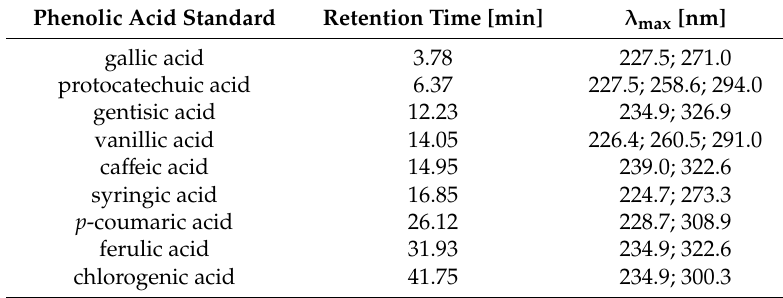
Table 4. Retention time in minutes and absorption maxima in the range 200–400 nm for phenolic acids in the HPLC method.